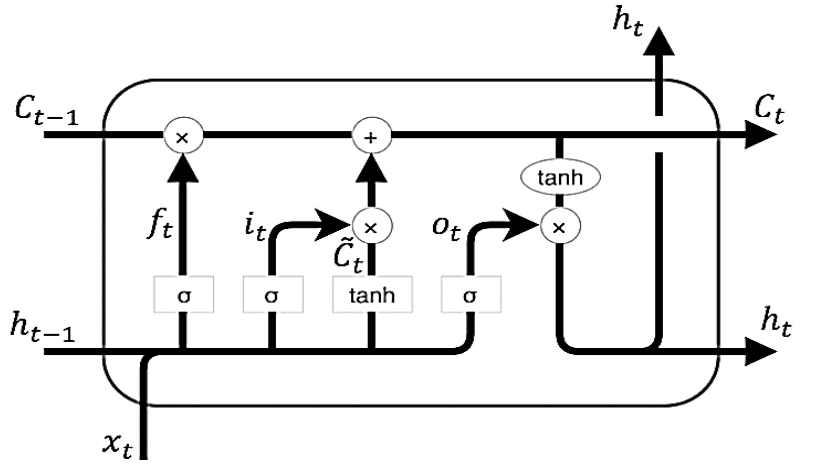
Figure A3. Basic Architecture of an LSTM Cell.